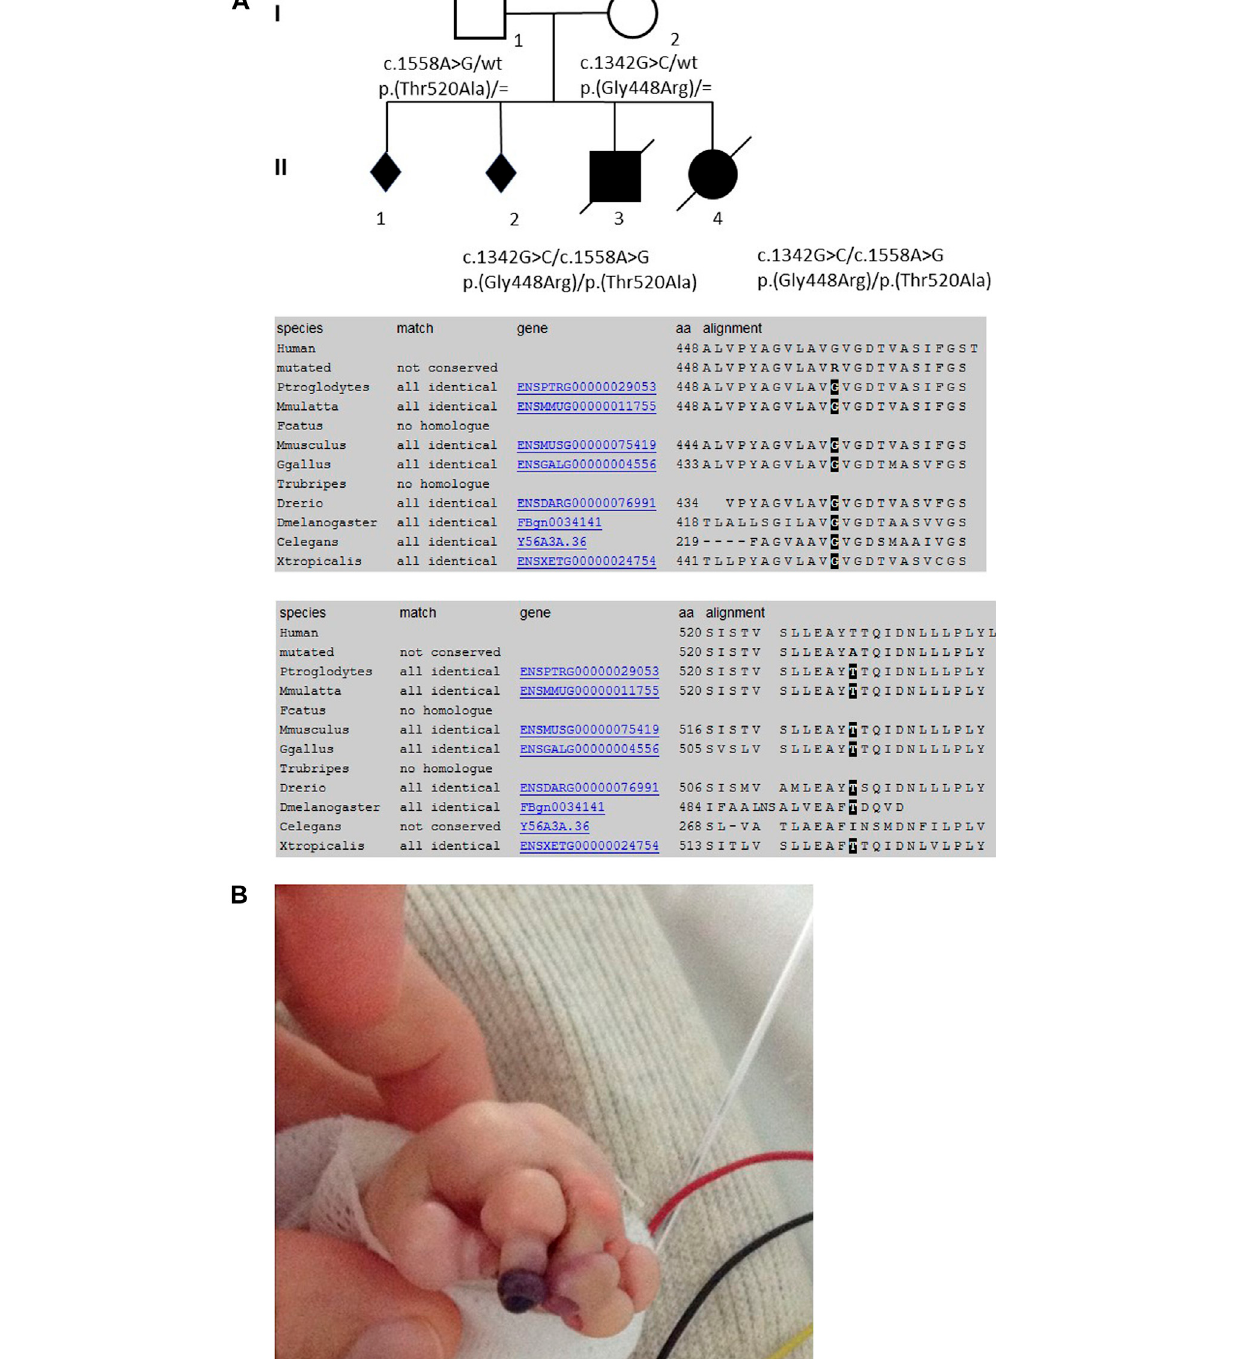
Frontiers in Genetics |